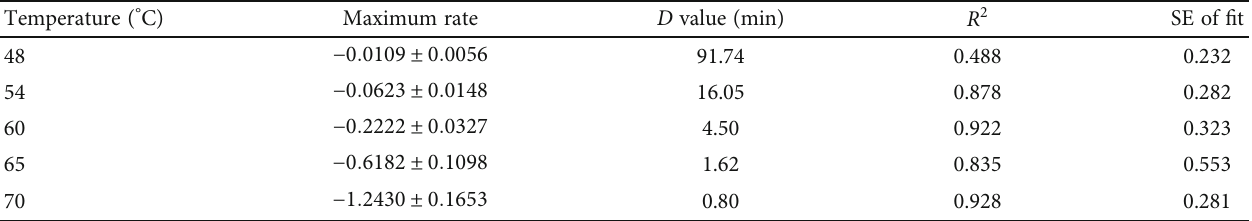
− 1 : 2430 ± 0 : 1653 Maximum rate values are the mean ± standarddeviation of three replicated experiments. Table 3: D values (obtained from linear regression) for a cocktail of two strains of Listeria monocytogenes inoculated in fresh curd during quesillo making at 48-70 ° C.